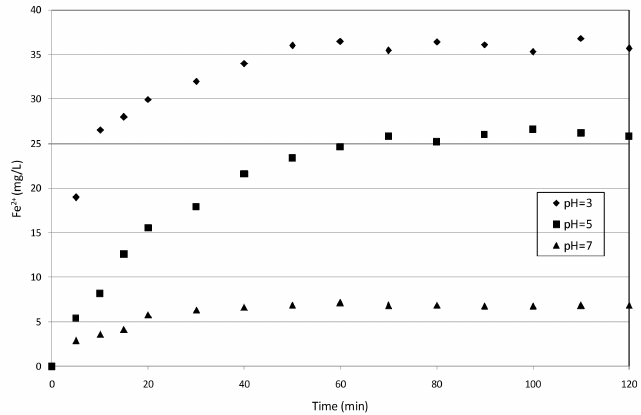
Figure 12. Fe 2+ concentrations detected during the tests conducted with mZVI and initial Pb 2+ concentration of 30